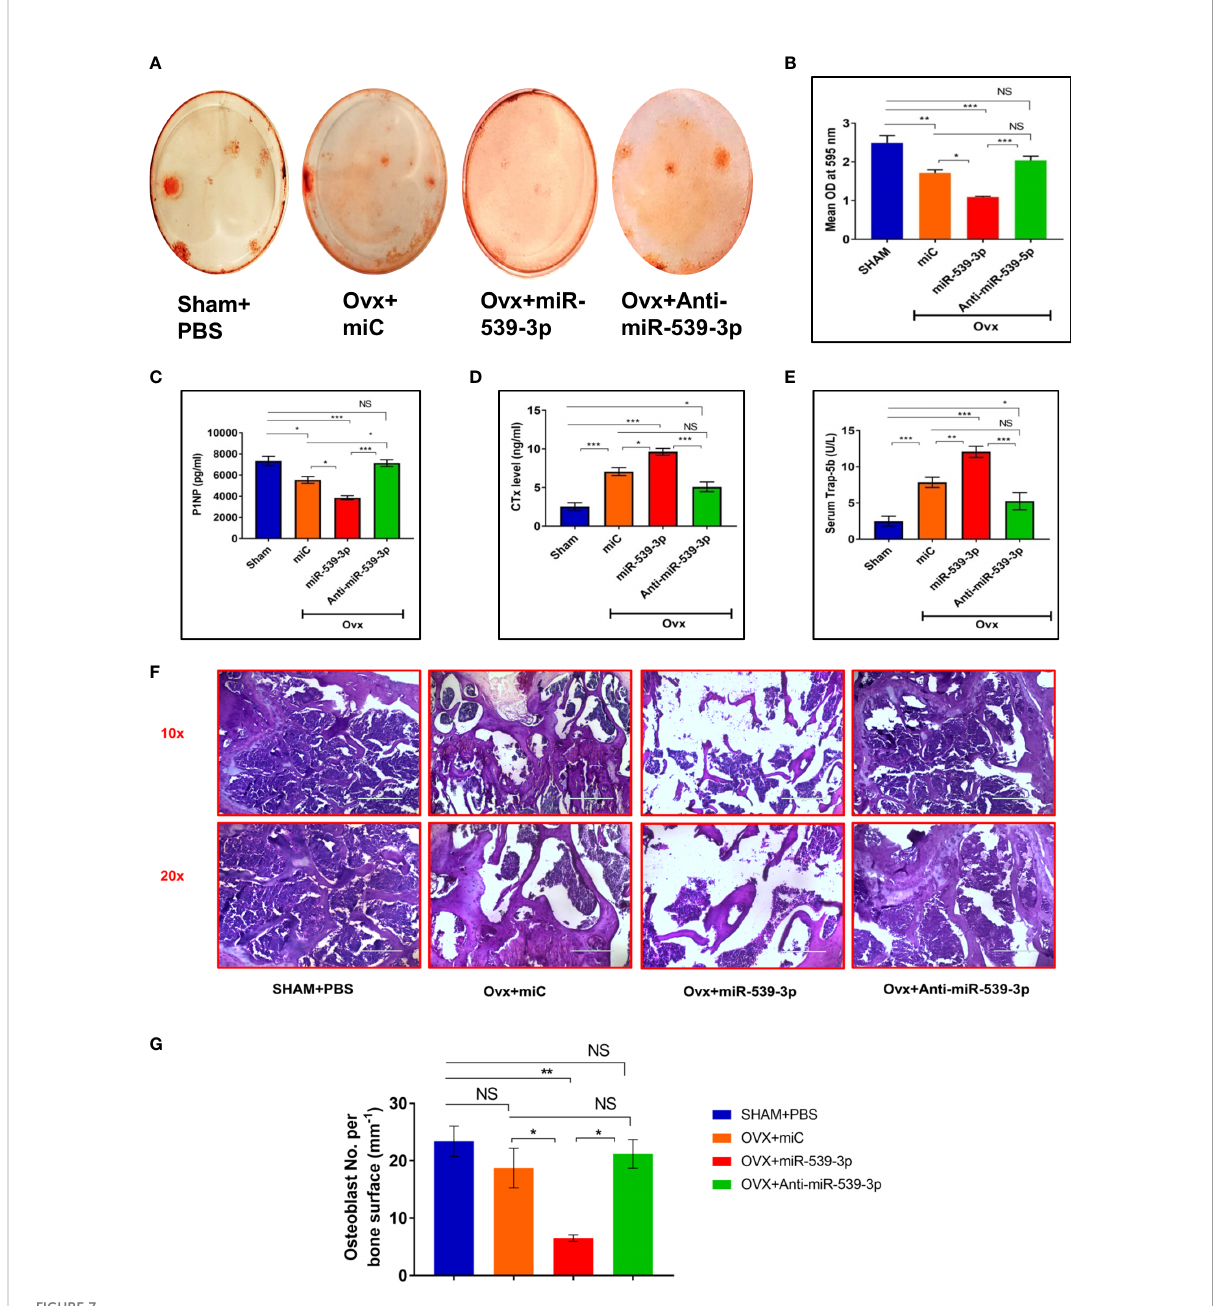
FIGURE 7 (A, B) Ex vivo mineralization representative images of femur bone and quanti fi cation. (C) Serum P1NP (D) Serum CTX-1. (E) Serum Trap-5b. (F) Representative HE images of different groups. (G) Quanti fi cation of osteoblast number per bone surface (n=3). All values represent means ± S.E. (n = 6). *P < 0.05, **P < 0.01, ***P < 0.001 and NS, non-signi fi cant compared in between the